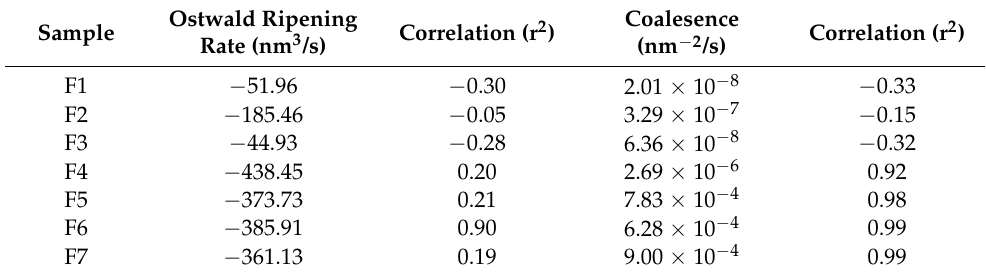
Figure 5. Variations in the average droplet size with time for different samples at room temperature. abcde , different letters indicate significant differences ( p > 0.05, one-way analysis of variance and Duncan’s test) in the parameters for different times. Table 3. Experimentally-determined Ostwald ripening and coalescence rate for a series of ZBEO